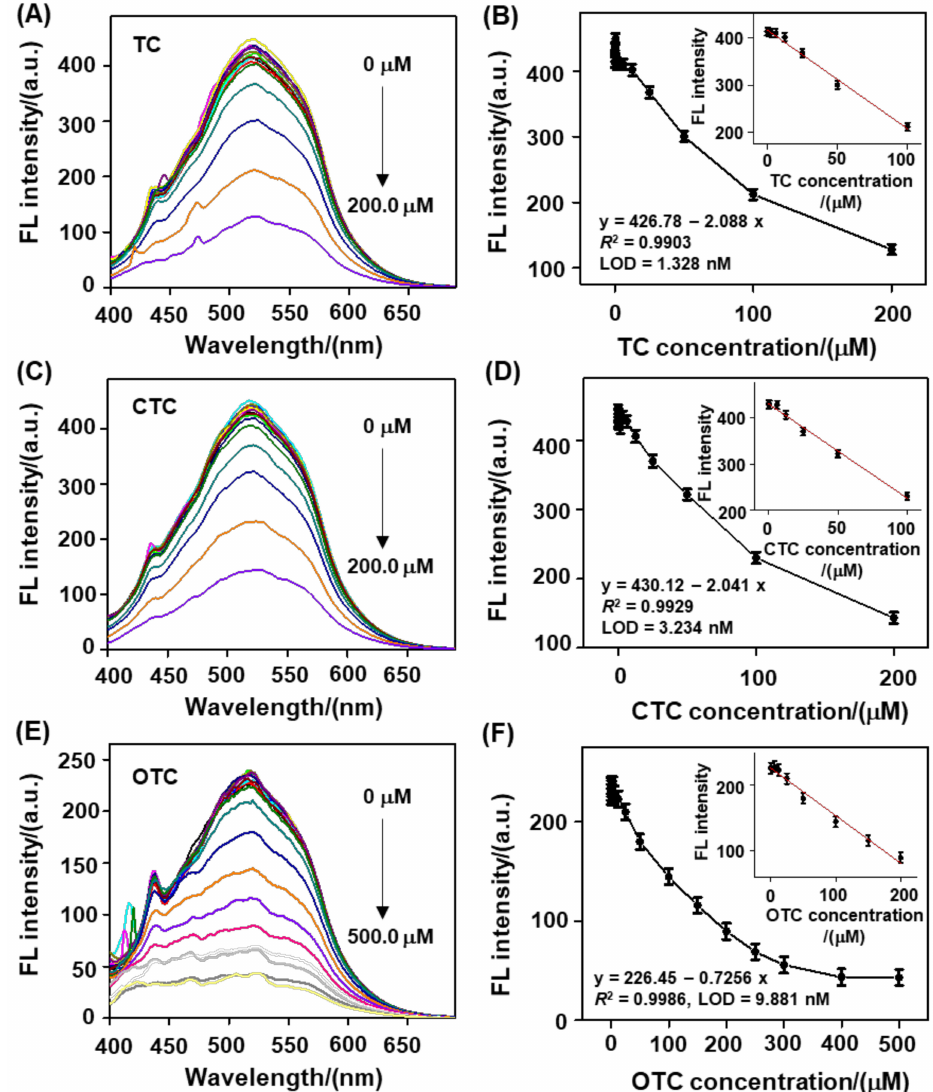
(Figure 4C) or 0.0 − 500.0 µ M (Figure 4E). The corresponding linear equation for CTC was F = 430.12 − 2.041 C ( R 2 = 0.9929), with an LOD of 3.234 nM in the linear range of 0.011 to 100.0 µ M (Figure 4D), and the linear equation for OTC was F = 226.45 − 0.7256 C ( R 2 = 0.9986), with an LOD of 9.881 nM in the linear range of 0.033 to 200.0 µ M (Figure 4F). As compared with other reported fluorescence assays (Table S1), the biomass-based C-dot- driven analytical platform displayed a wider linear range, as well as comparable or even better sensitivity for monitoring of residual TCs. More significantly, these LODs were below the maximum allowable residue defined by China (100.0 mg/kg) and the European Union (225.0 nM) [46]. These results strongly imply that the proposed biomass-based C − dots are prominently sensitivity toward TCs, with practical potential for accurate traceability analysis of residual TCs in complex environmental matrices.